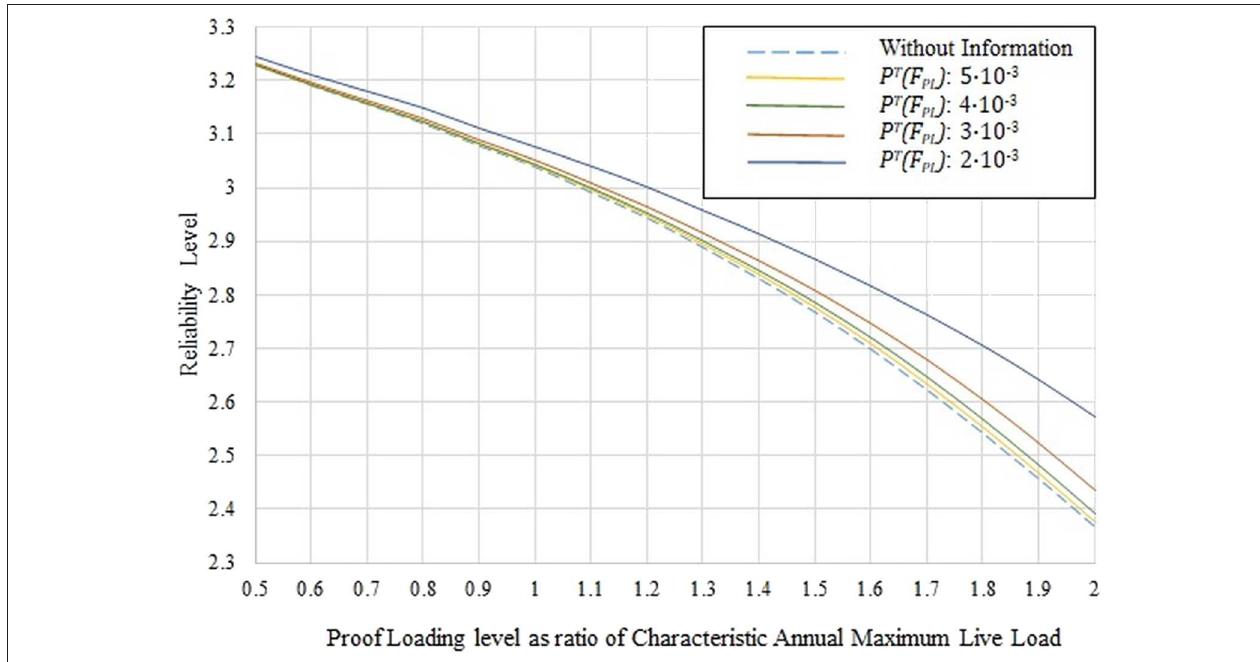
FIGURE 8 | Reliability level of the bridge during testing following indication event Z 1 with the different stop criteria